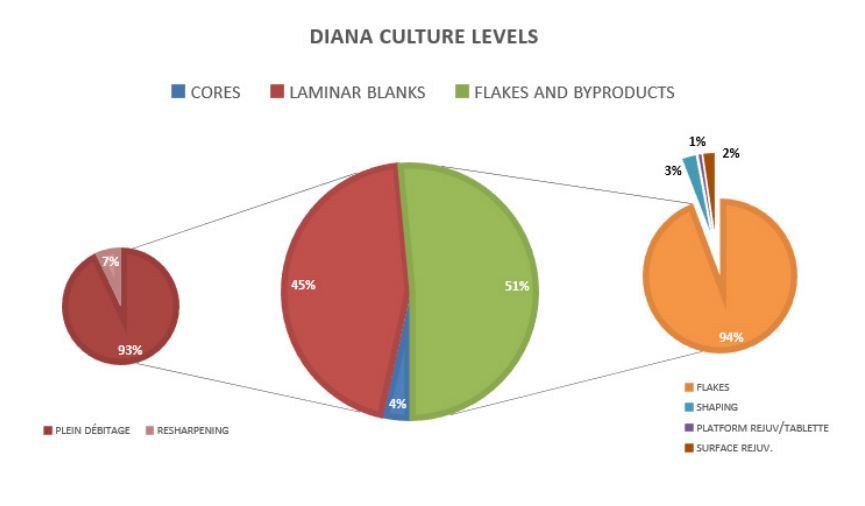
Figure 10 . S. Martino. Distribution of the obsidian knapping products from Diana occupation levels.